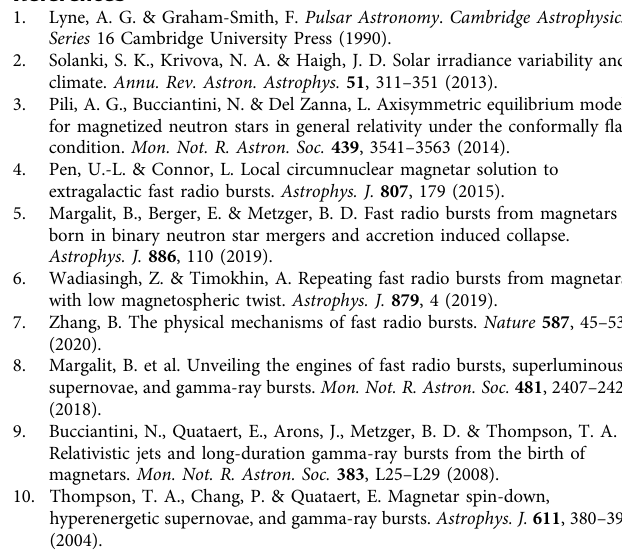
Fig. 5 Single-point FFT spectrum obtained from the Gmunu simulation of T1K6 model under l = 0 perturbation. The FFT data are computed from the time evolution of the r -component of three velocity fi elds at the spatial point ( r , θ ) ≃ ( r e /2, π /2). The parabolic interpolations of the prominent peaks are shown as an example. The FFT spectrum at a single spatial point usually shows peaks that are sharp enough for